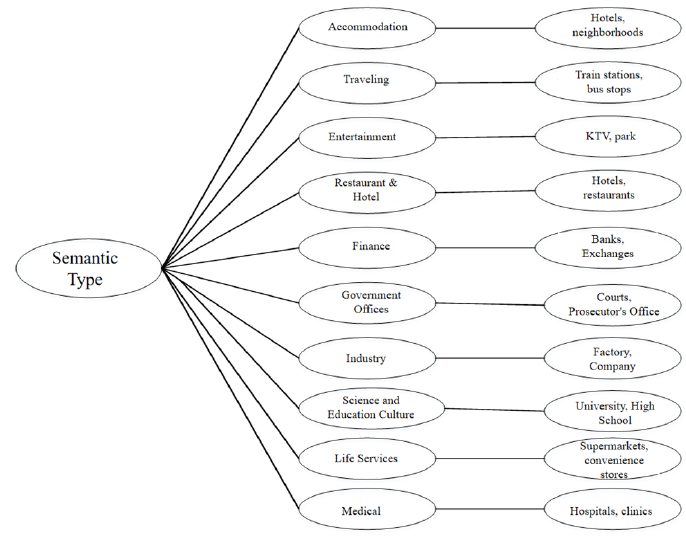
Figure 11. Semantic type classification.